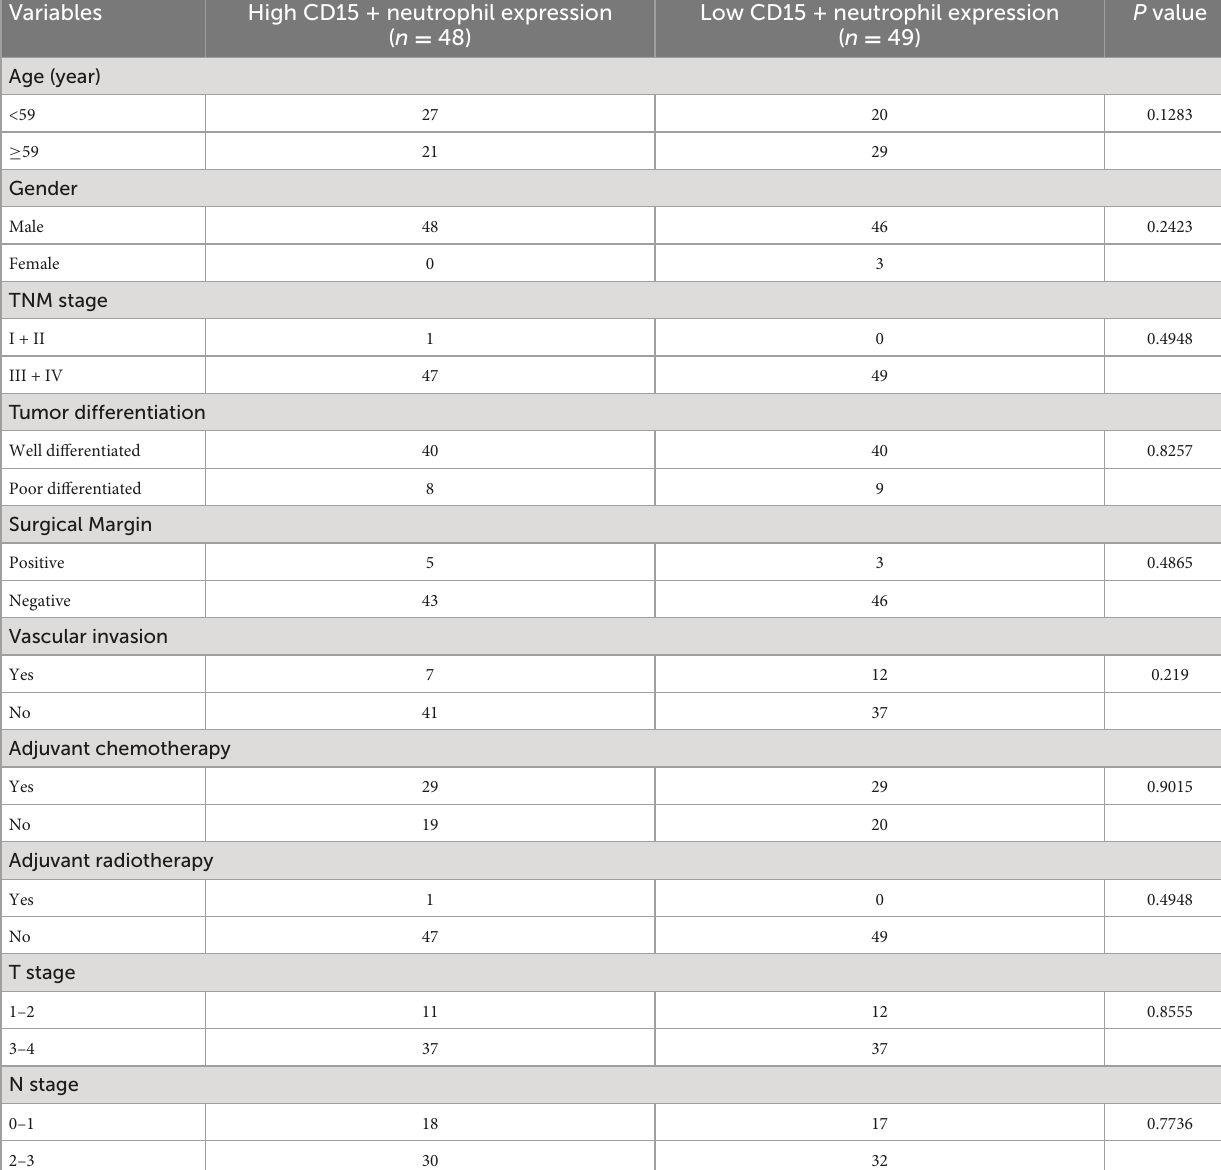
TABLE 5 The relationship between peritumoral CD15 + neutrophil level and clinical characteristics.